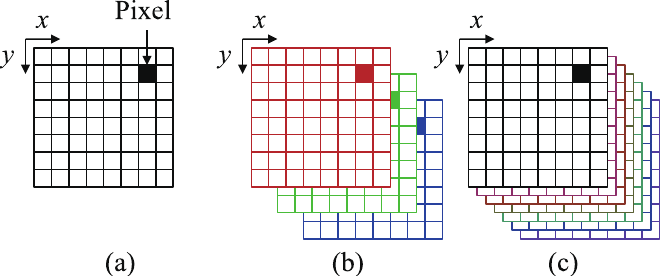
Figure 2. Explanation of multi-channel image: ( a ) Grayscale image with single channel, ( b ) RGB color image with 3 channels, and ( c ) multispectral image with 7